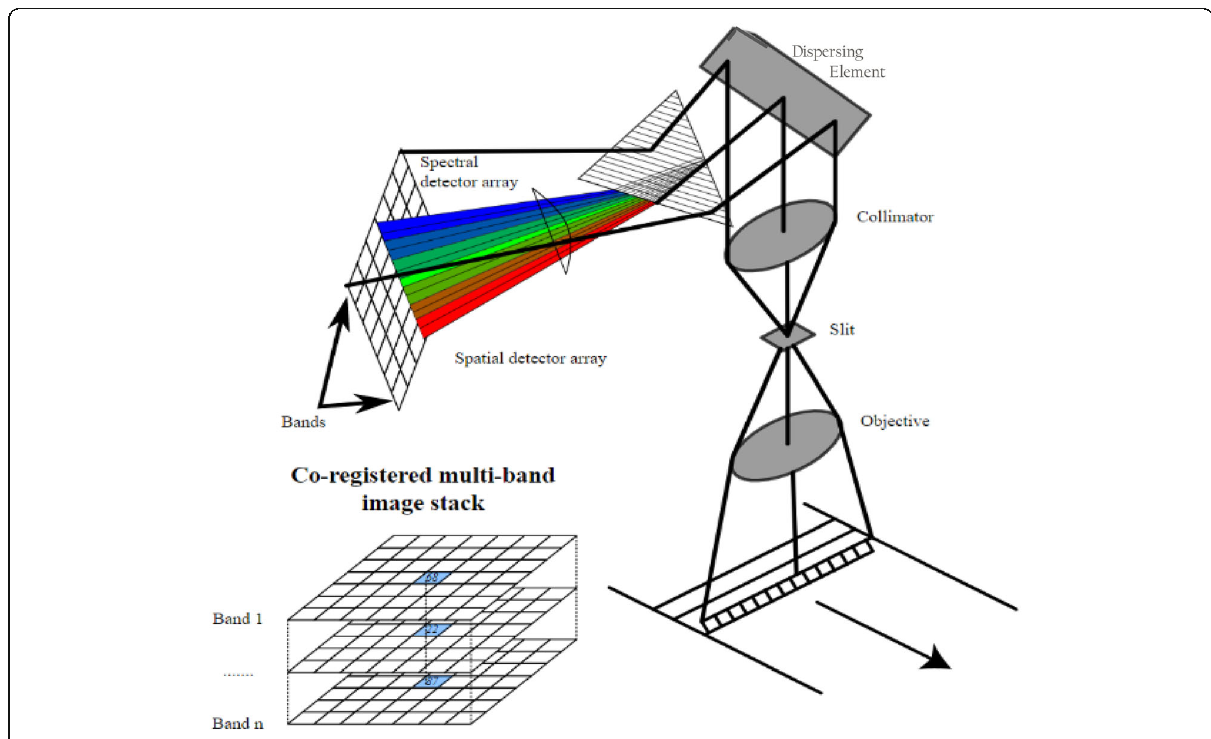
Fig. 15 Imaging spectrometers measure a full spectrum for each pixel. Light from each pixel area enters the objective and is directed through the entrance slit and onto a collimator before it intersects the dispersing element, such as a prism (as for PRISMA) or a diffraction grating, which disperses the light into different wavelength intervals onto the spectral detector array (as for EnMAP), which dispurses light onto the spectral detector array (one detector per spectral band). Prior to the dispersing element, both PRISMA and EnMAP split the light into two pathways, with different spectral detectors for the VNIR spectrum and the other for the SWIR spectrum. Figure modified from a license under the